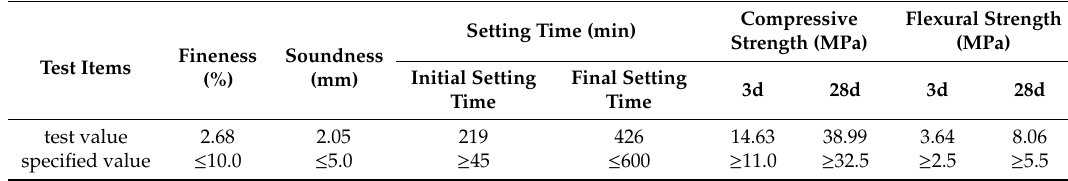
Table 2. Technical properties of